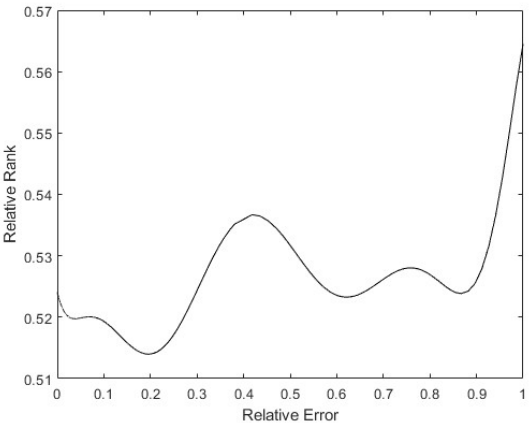
Figure 28. Polynomial regression of relative rank to relative error on X 2 .